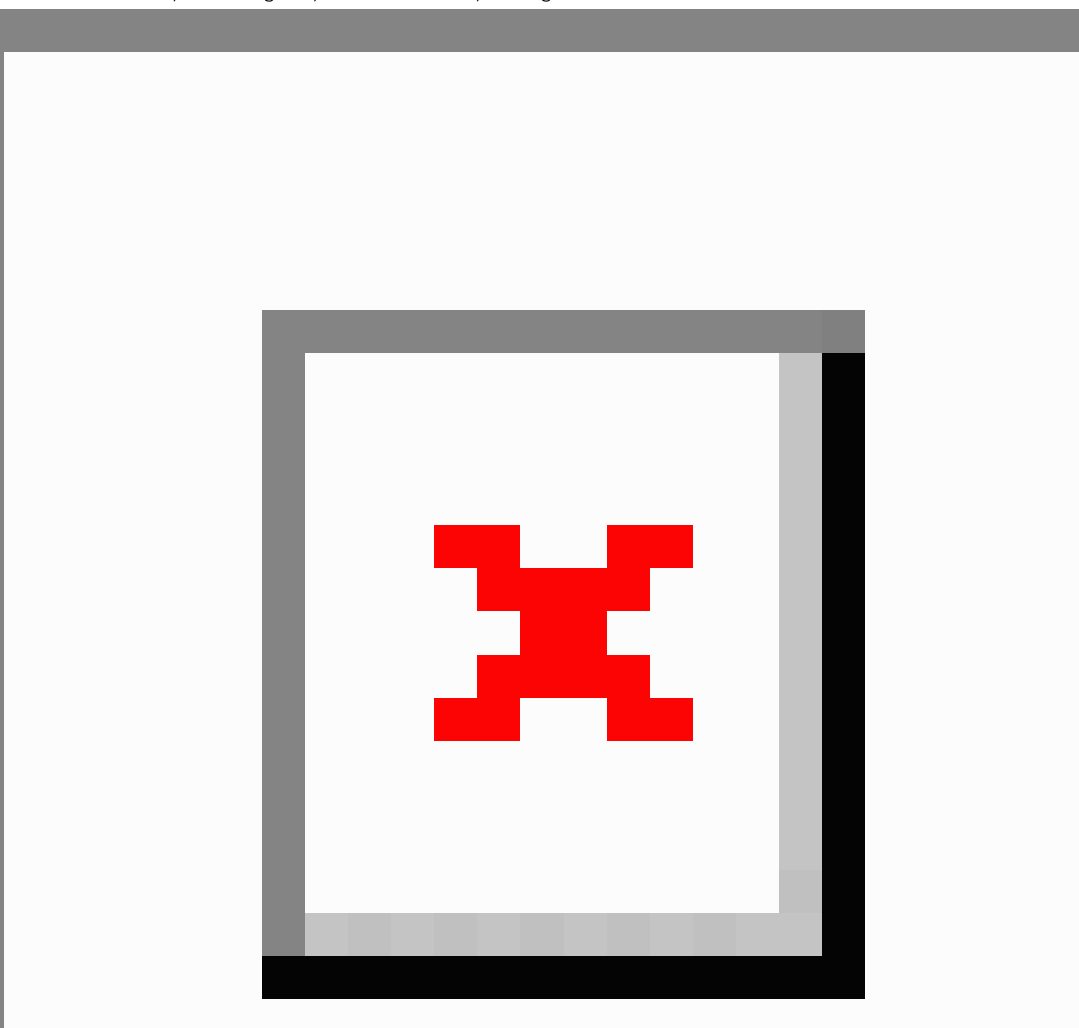
Figure 2. Example of heart age calculator results for ID91: male, age 48, BP and cholesterol unknown. A: New Zealand, initial absolute risk result 3% but estimate increased to 5%; B: heart age 58; C: Unilever result, heart age